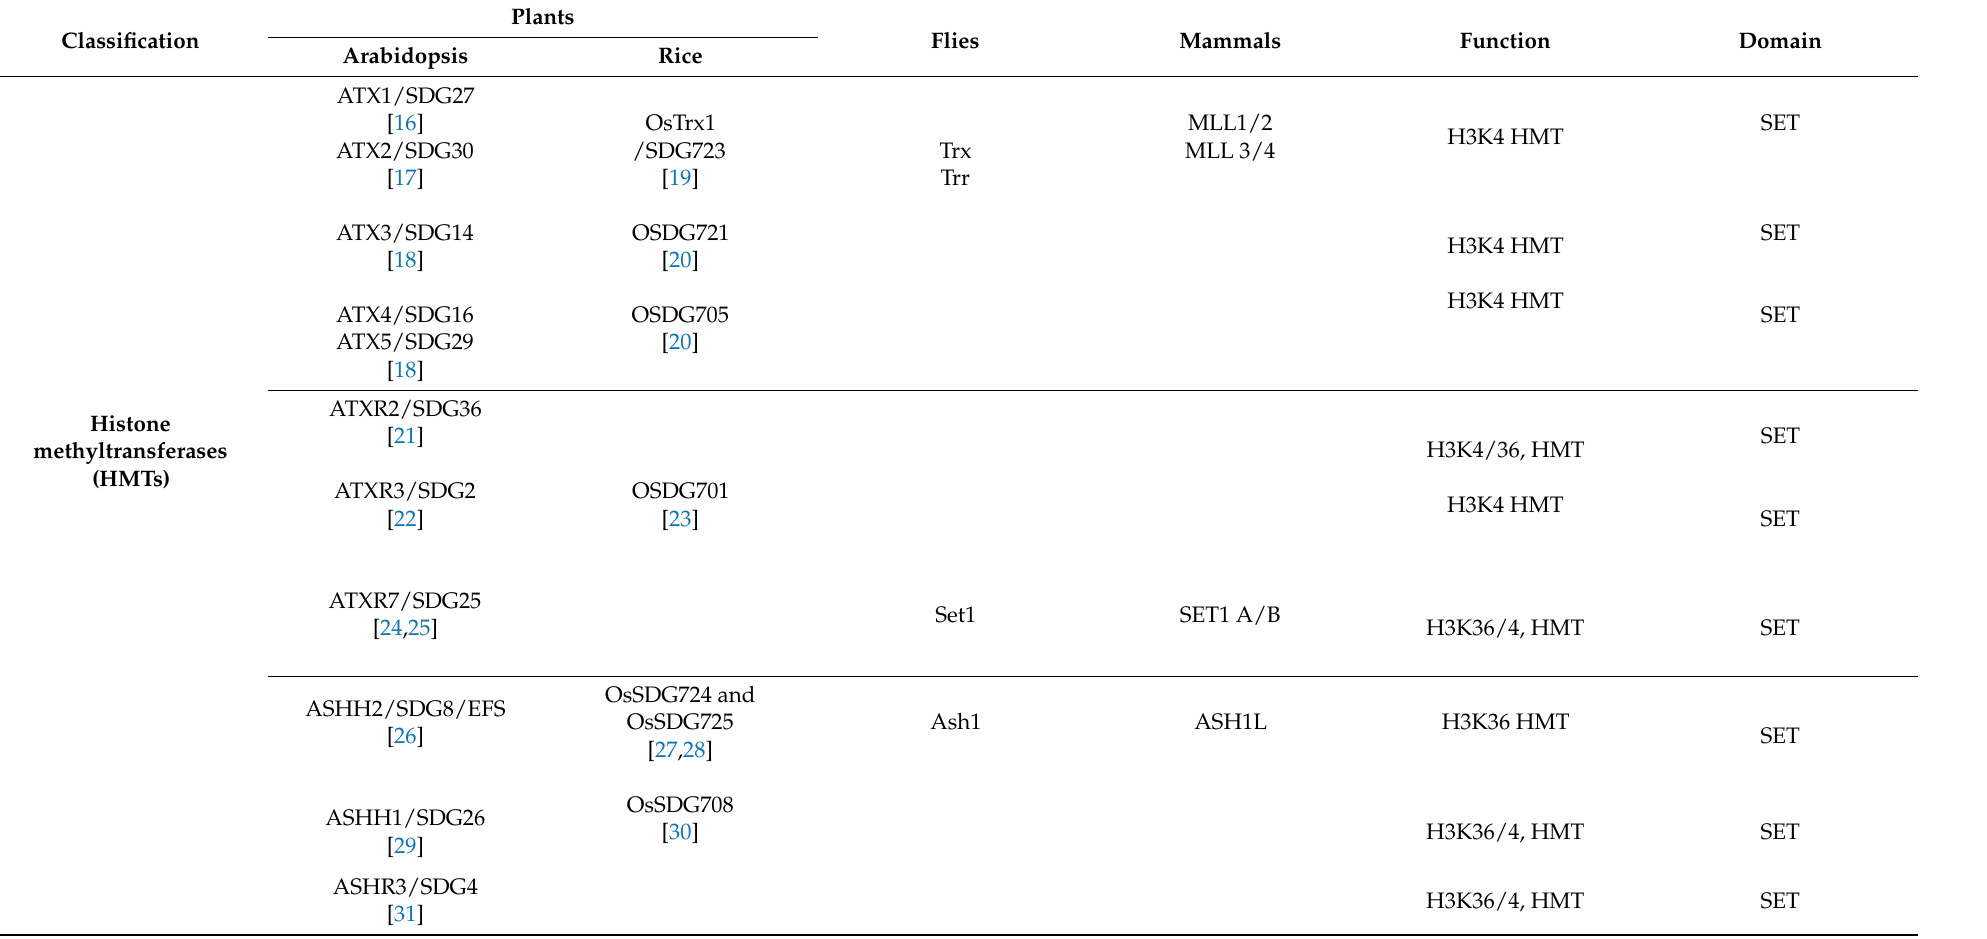
Table 1. List of Arabidopsis TrxG components. TrxG proteins are listed by their classification, showing molecular function, domain associated, as well as their homologs in rice, Drosophila melanogaster (flies), and